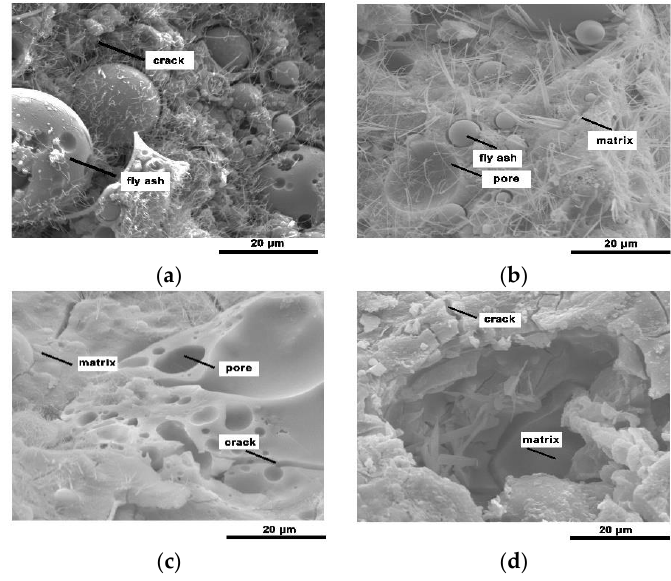
Figure 2. Scanning electron microscope (SEM) images of the obtained geopolymers: ( a ) NaOH-1; ( b ) NaOH-2; ( c ) NaOH-3; ( d ) NaOH-4.